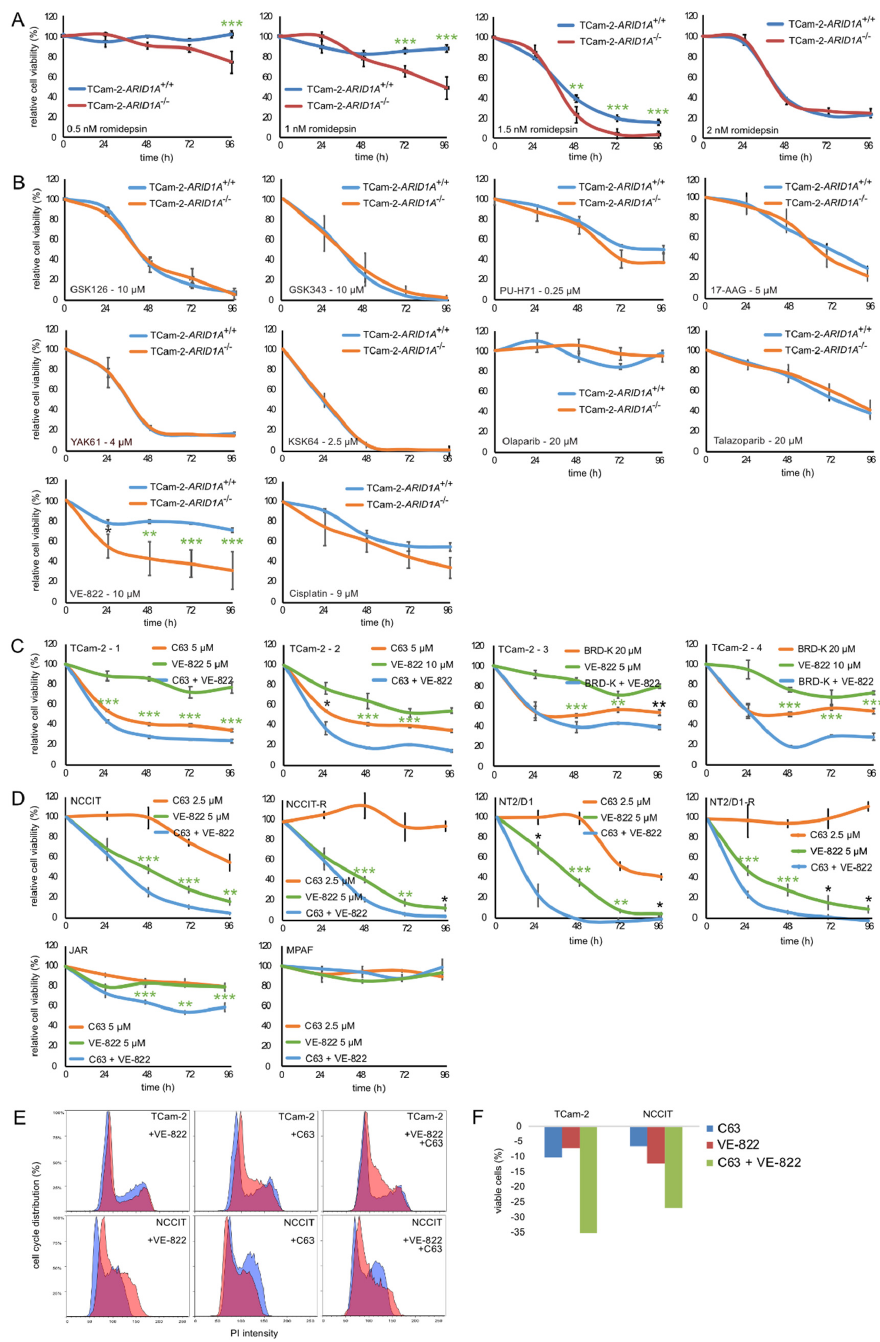
Figure 2. (A) XTT data of TCam-2- ARID1A +/+ and - ARID1A -/- clones (average) treated once with 0.5–2 nM Figure 2. ( A ) XTT data of TCam-2- ARID1A +/+ and - ARID1A − / − clones (average) treated once with romidepsin. ( B) XTT data of TCam-2- ARID1A +/+ and - ARID1A -/- clones (n = 4) treated once with EZHi 0.5–2 nM romidepsin. ( B ) XTT data of TCam-2- ARID1A +/+ and - ARID1A − / − clones (n = 4) treated GSK126 or GSK343 (both 10 μ M), PARPi olaparib or talazoparib (both 20 μ M), HSP90i PU-H71 (0.25 μ M) once with EZHi GSK126 or GSK343 (both 10 µ M), PARPi olaparib or talazoparib (both 20 µ M), HSP90i or 17-AAG (5 μ M), HDAC6i YAK61 (4 μ M) or KSK64 (2.5 μ M), cisplatin (9 μ M) and ATRi VE-822 (10 PU-H71 (0.25 µ M) or 17-AAG (5 µ M), HDAC6i YAK61 (4 µ M) or KSK64 (2.5 µ M), cisplatin (9 µ M) and μ M). ( C) XTT data of TCam-2- ARID1A +/+ cells treated with C63 (5 μ M) or BRD-K (20 μ M) alone or in ATRi VE-822 (10 µ M). ( C) XTT data of TCam-2- ARID1A +/+ cells treated with C63 (5 µ M) or BRD-K (20 µ M) alone or in combination with VE-822 (5 µ M, 10 µ M). ( D ) XTT data of NCCIT(-R), NT2 / D1(-R) and JAR cells treated with C63 and / or VE-822. As control, MPAF fibroblasts were included. A–D) Changes in viability (compared to solvent treated controls) were measured over 96 h. p -values * < 0.05, ** < 0.005, *** < 0.0005; p -values labelled in green were still significant after correction for multiple testing. ( E , F ) PI- and Annexin V-based flow cytometry analysis of cell cycle phase distribution ( E ) and apoptosis rates ( F ) in TCam-2 and NCCIT cells treated with C63 and / or VE-822 for 24